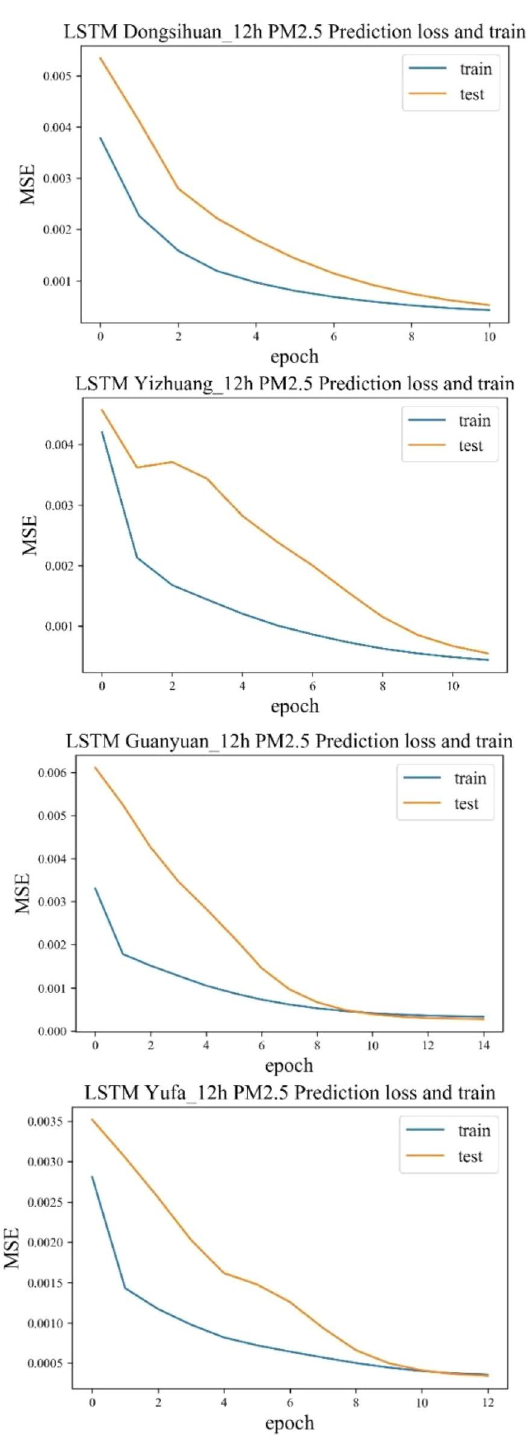
Figure.9. Error comparison between LSTM 12-h input PM 2.5 training set and test